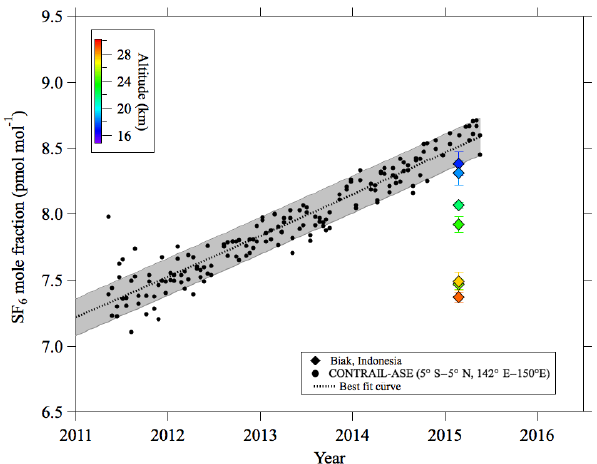
Figure 5. Same as Fig. 4 but for SF 6